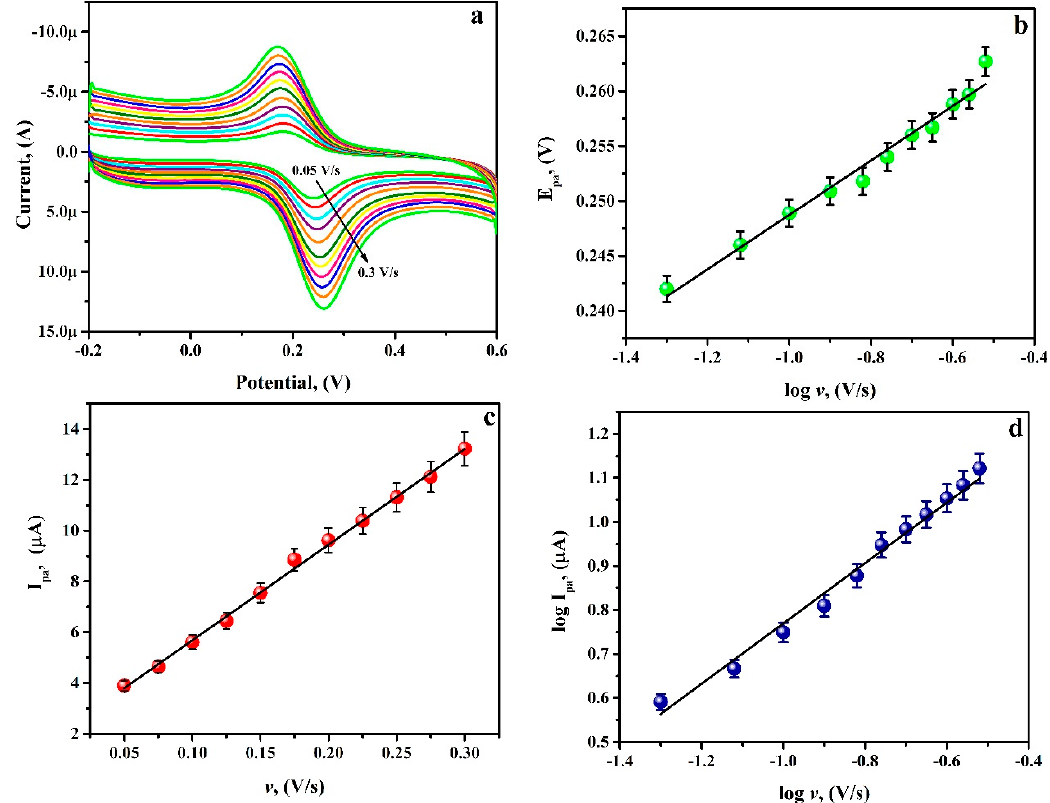
Figure 8. ( a ) CVs for 0.1 mM RU at PGAMGPE in pH 6.5 at different scan rates ranging from 0.050 to 0.30 V/s. ( b ) Graph of E pa versus log ʋ . ( c ) Graph of I pa versus ʋ . ( d ) Graph of log I pa versus log ʋ .